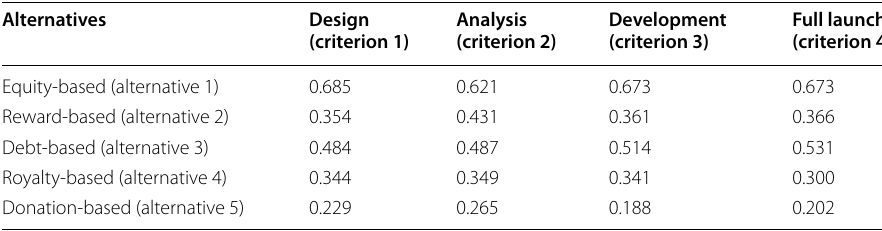
Table 23 Normalized decision matrix